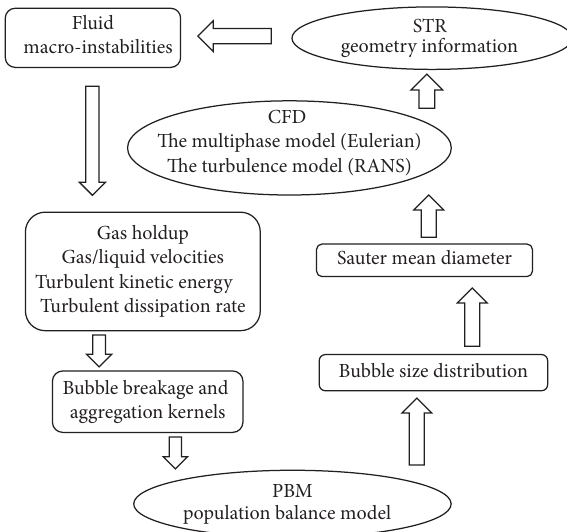
Figure 1: Bubble SMD in the framework of the CFD-PBM simula-